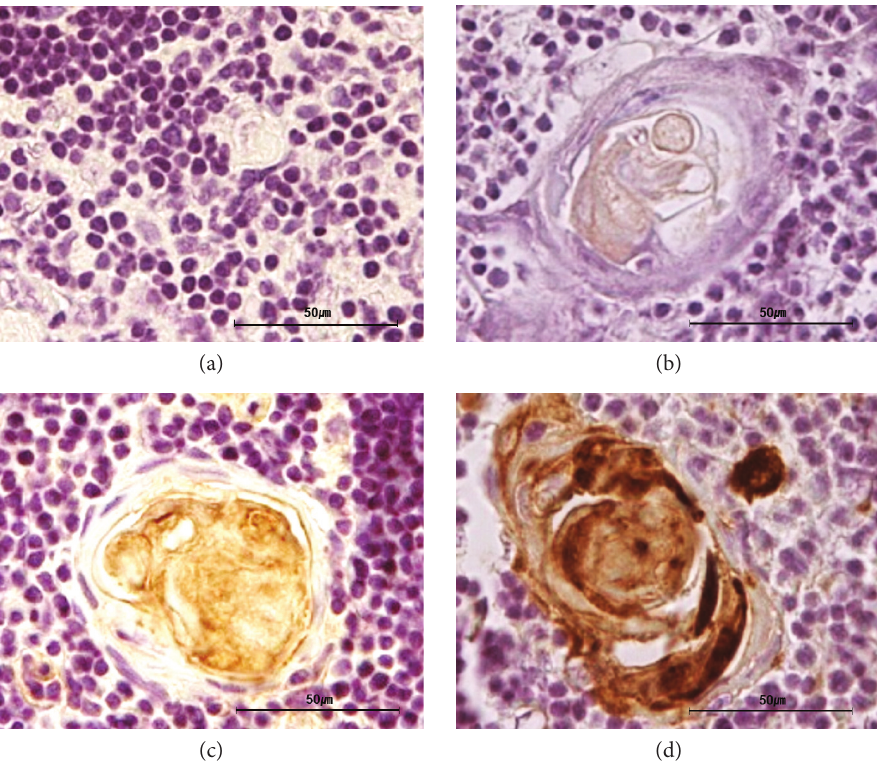
Figure 1: Expression of thyroid-related proteins in the thymus by immunohistochemistry with a 4-point scoring system. Representative images of score 0 (a), 1 (b), 2 (c), or 3 (d) are displayed. All images are magni fi ed 400x, and the scale bars represent 50 μ